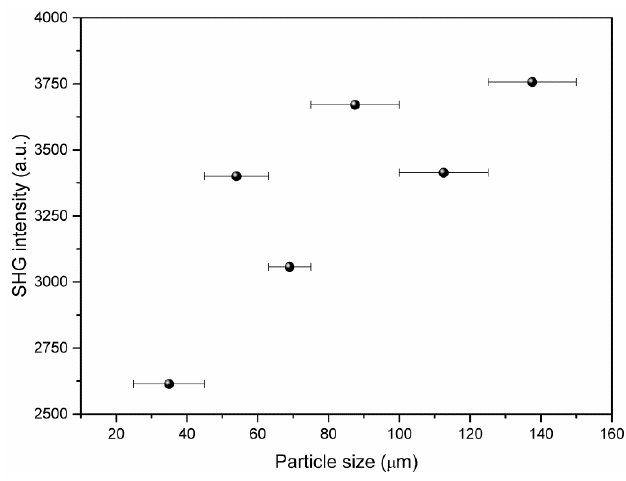
Figure 10. Observed dependence of second harmonic generation (SHG) intensity (using 800 nm fundamental laser line) on particle size for (2-AMP) 3 (H 3 BO 3 ) 2 .